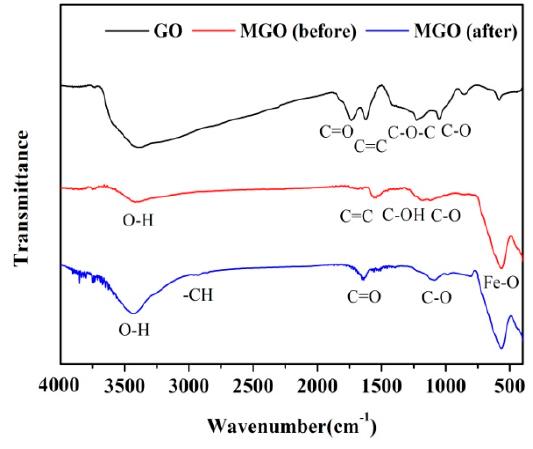
Figure 3. FTIR spectra of GO and MGO before and after the adsorption of estrogens.